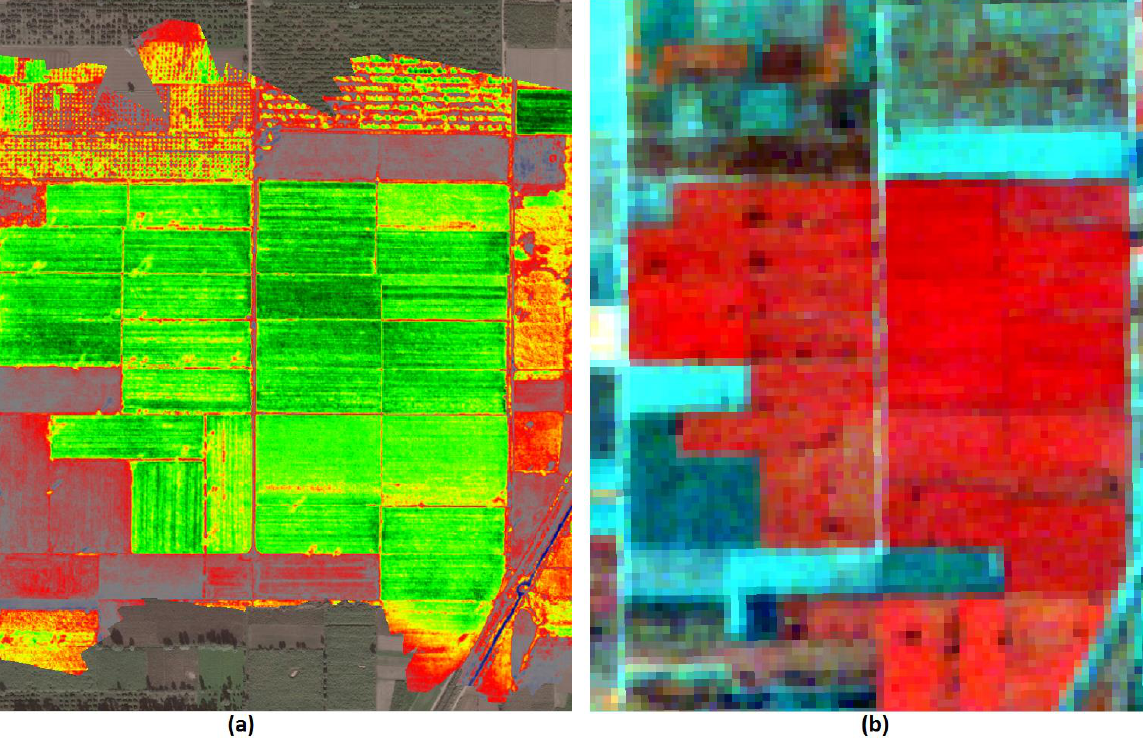
Figure 13. NDVI Image comparison (a) UAS image (b) Satellite (Sentinel-2A)